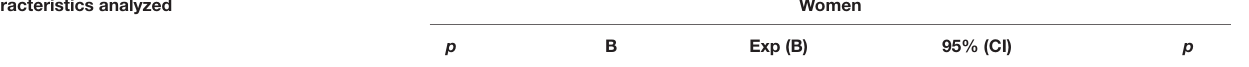
TABLE 6 | Logistic regression analyses of characteristics related to complications in 41-79 years old women patients with chronic subdural hematoma. Characteristics